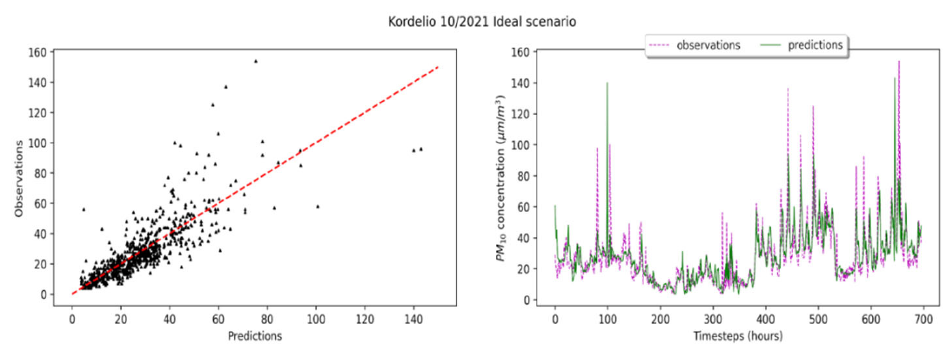
Figure 15. Calibrated output from 5 O 3 LCS not involved in the training. nkastom## refers to the code id of the node.